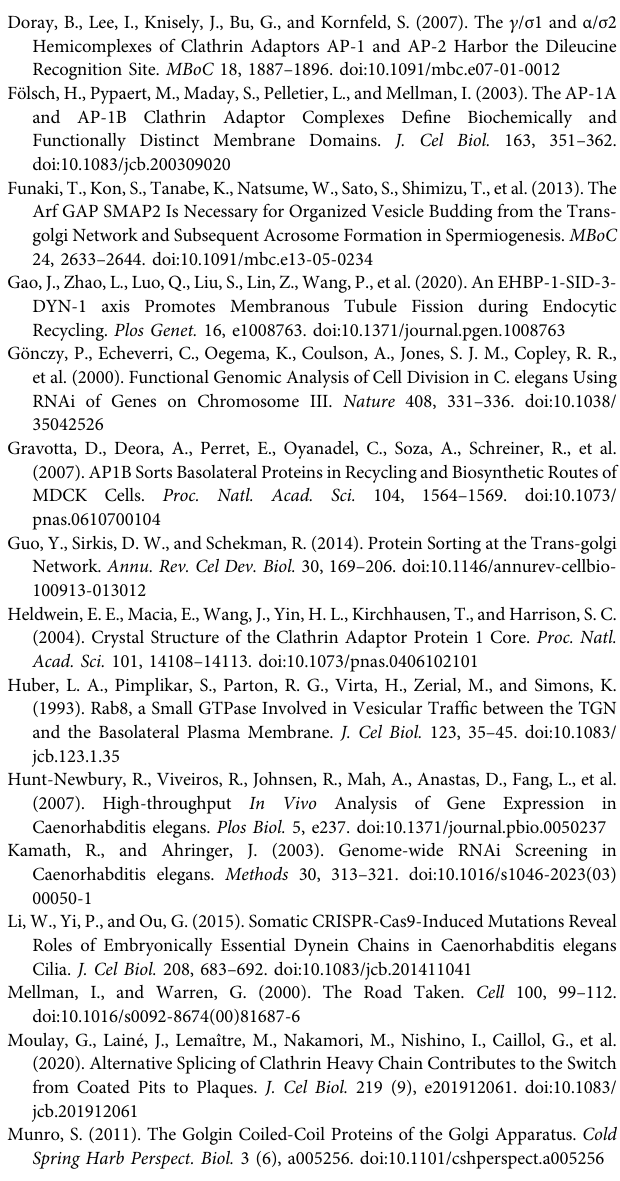
Supplementary Figure S6 | (A-A 9 ) Confocal images of the intestinal cells expressing GFP-tagged ERM-1 and SLCF-1. Asterisks in the panels indicate intestinal lumen. Error bars are 95% CIs ( n (cid:1) 18 each, 9 animals of each genotype were sampled in whole-cell regions of two intestinal cells). Asterisks indicate the signi fi cant differences in a one-way ANOVA followed by a post-hoc test (Dunn ’ s Multiple Comparison Test) for multiple comparisons (*** p < 0.001). (B- B 9 ) Confocal image showing colocalization between GFP-APM-1 ( μ 1 subunit) and SMAP-1-mCherry in the intestinal cells. Arrowheads indicate structures labeled by both GFP and mCherry. Pearson ’ s correlation coef fi cients for GFP and mCherry signals are calculated, error bars are 95% CIs ( n (cid:1) 12 animals). (C-C 9 ) Confocal images showing CHC-1-GFP in the intestinal cells. Error bars are 95% CIs ( n (cid:1) 18 each, 9 animals of each genotype were sampled in whole-cell regions of two intestinal cells). Asterisks indicate the signi fi cant differences in the Mann-Whitney test (ns: no signi fi cance). Scale bars, 10 μ m. Supplementary Figure S7 | In the C. elegans intestine, ARF-1.2 regulates clathrin coat assembly via downstream AP-1 and SMAP-1, promoting TGN sorting. In addition, SMAP-1 acts as a GAP to regulate ARF-1.2 activity in a negative feedback